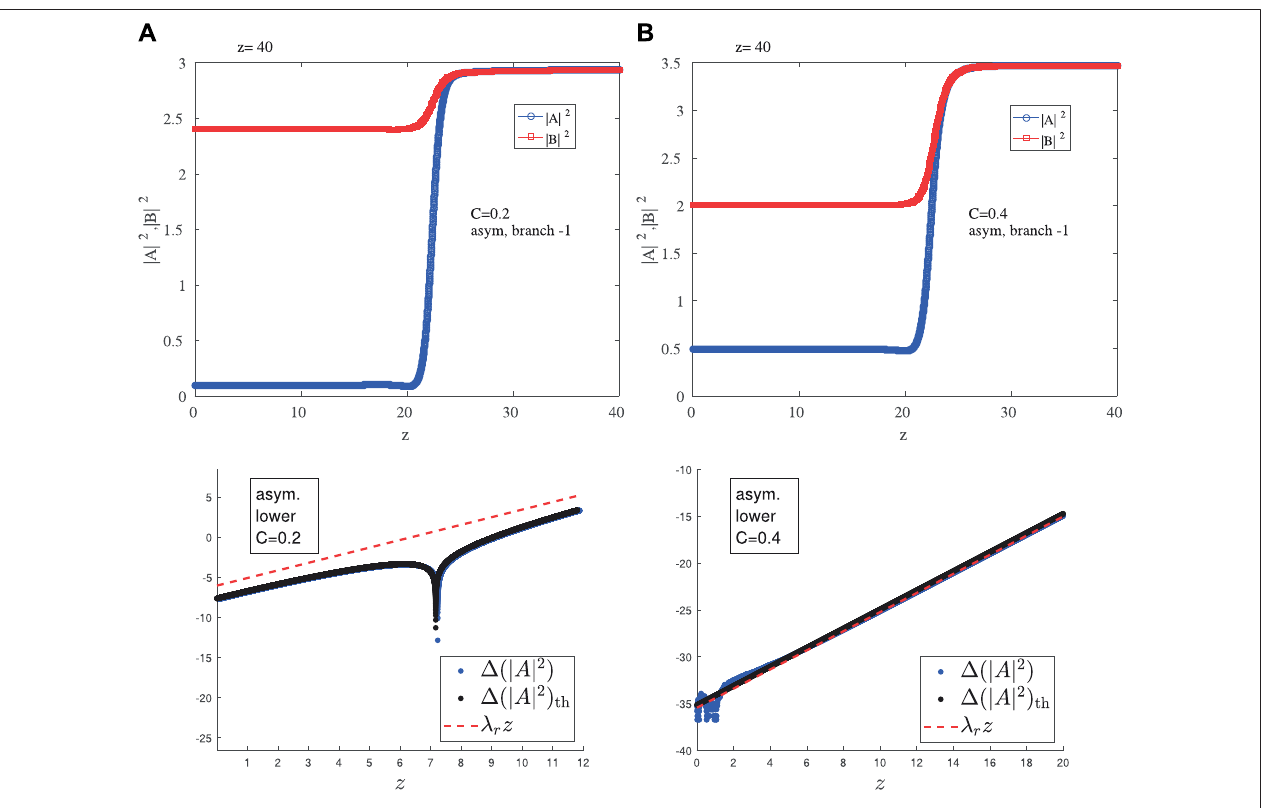
FIGURE10| Evolutionofsteady state solutionsfrom the asymmetric lowerbranch (A) C =0.2 (B) C =0.4. See text forother parameter values.The fi gure issimilar to Figure 9 , however for this branch the case of C = 0.2 has a complex pair, while that of C = 0.4 possesses only real eigenvalues; cf. Figure 6 .